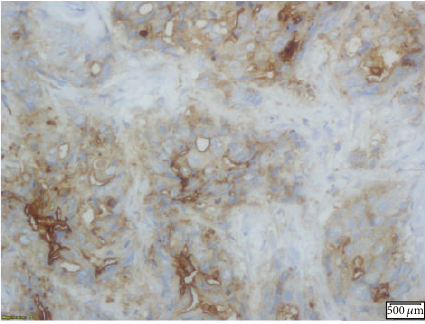
Figure 5: IHC stain positive for polyclonal CEA.